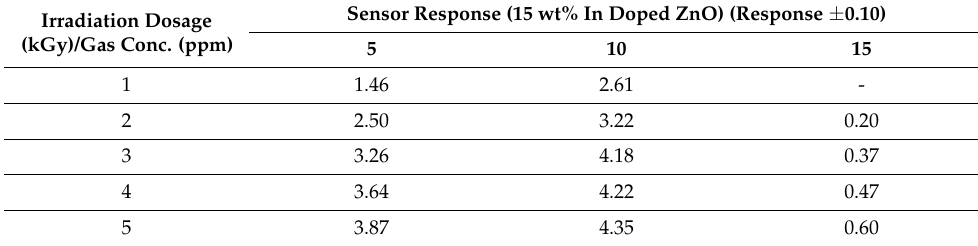
Table 3. Response of irradiated IZO sensors.